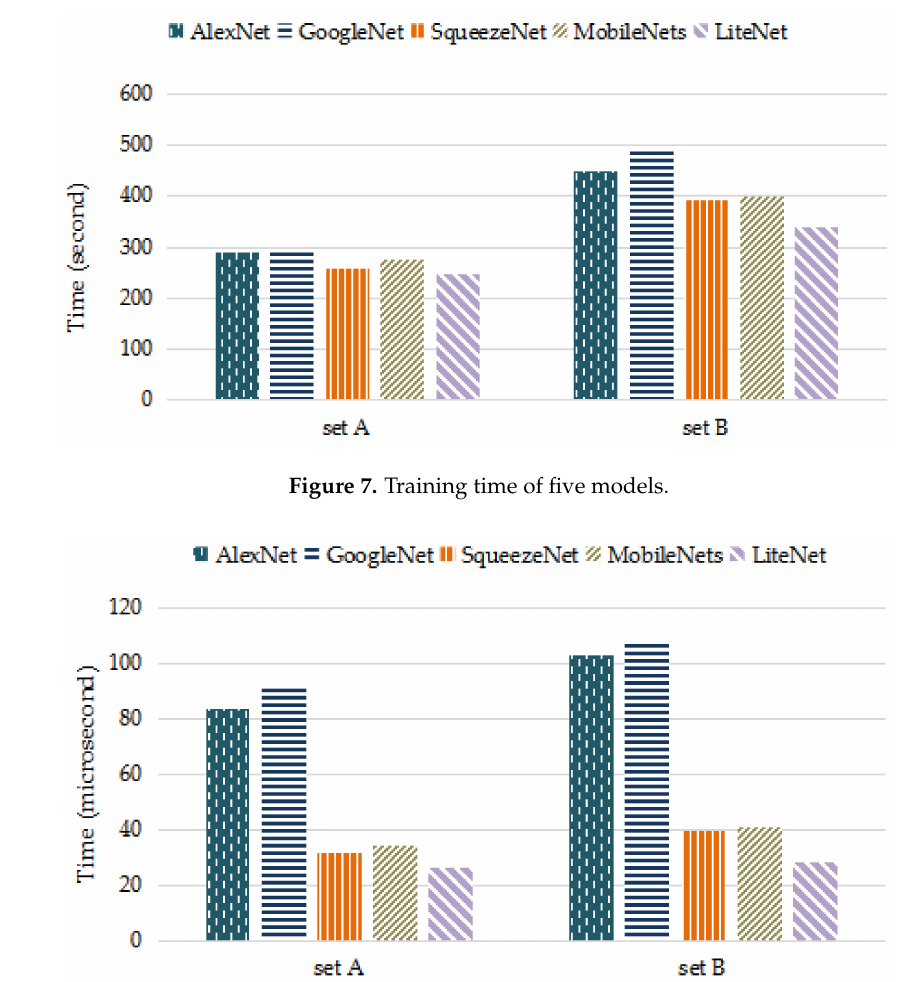
Figure 8. Testing time of five